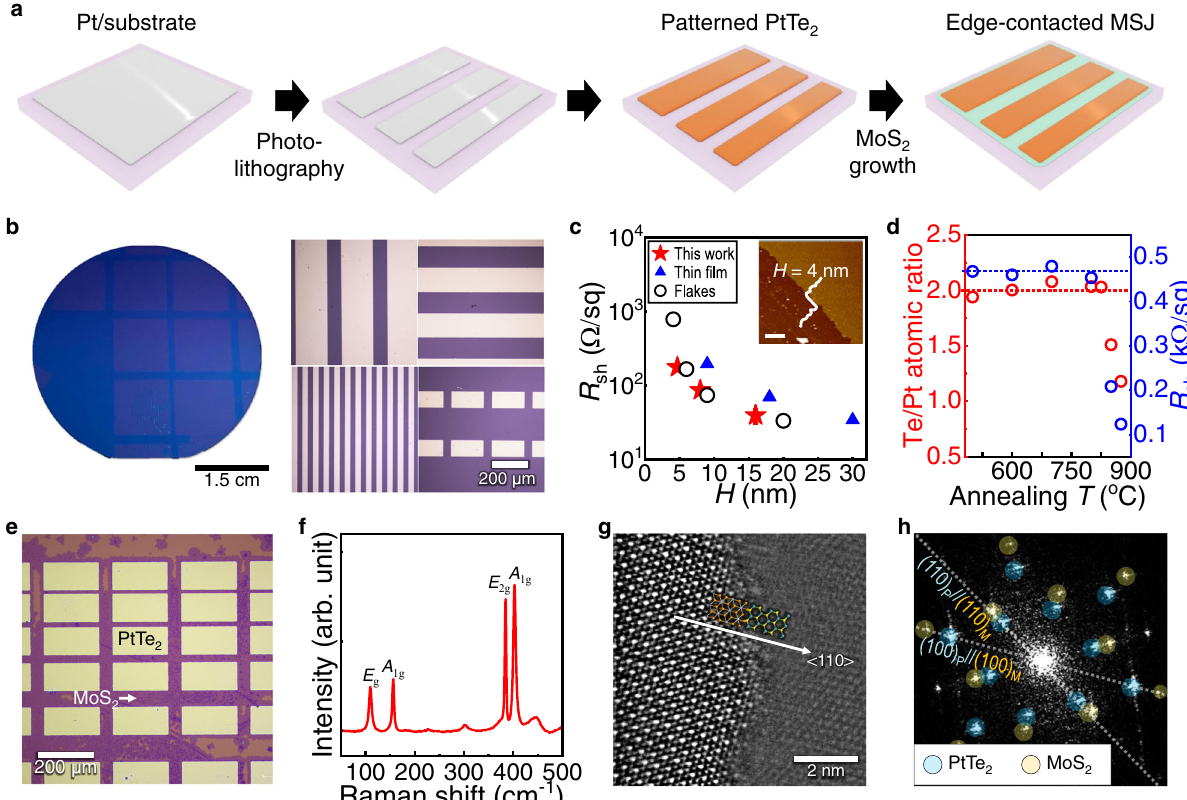
Fig. 3 | Wafer-scalegrowthofPtTe 2 patterns for syntheticedgecontact arrays. a Schematic of procedure for realizing PtTe 2 -MoS 2 heterostructure arrays in a position-controllable manner, involving photolithography before the tellurization of Pt. b Photograph image of as-grown large-scale PtTe 2 patterns on a 2-inch-scale SiO 2 /Si substrate (left), and representative OM images of the thin fi lm captured on the left image (right). c Sheet resistance ( R sh ) of as-grown PtTe 2 thin fi lm as a function of the fi lm thickness ( H ), characterized by four-probe method. R sh values for high-quality PtTe 2 from previous reports 27,53 are displayed for comparison. The inset shows a representative AFM image of the as-grown thin fi lm (scalebar: 1 μ m). d (left) XPS-derived atomic ratio of the thin fi lm, showing the nearly ideal stoi- chiometryofPtTe 2 (at.%(Te/Pt) ≈ 2;dashedredline)irrespectiveto T upto825°C, (right) R sh of thin fi lms as a function of annealing T , with R sh ~467 Ω /sq (for T =